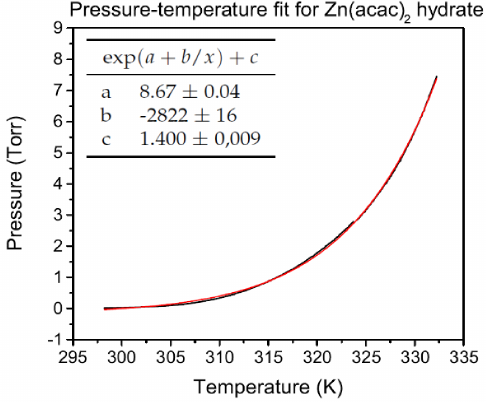
Figure 2. Fit of hydrate zinc acetylacetonate vapor pressure